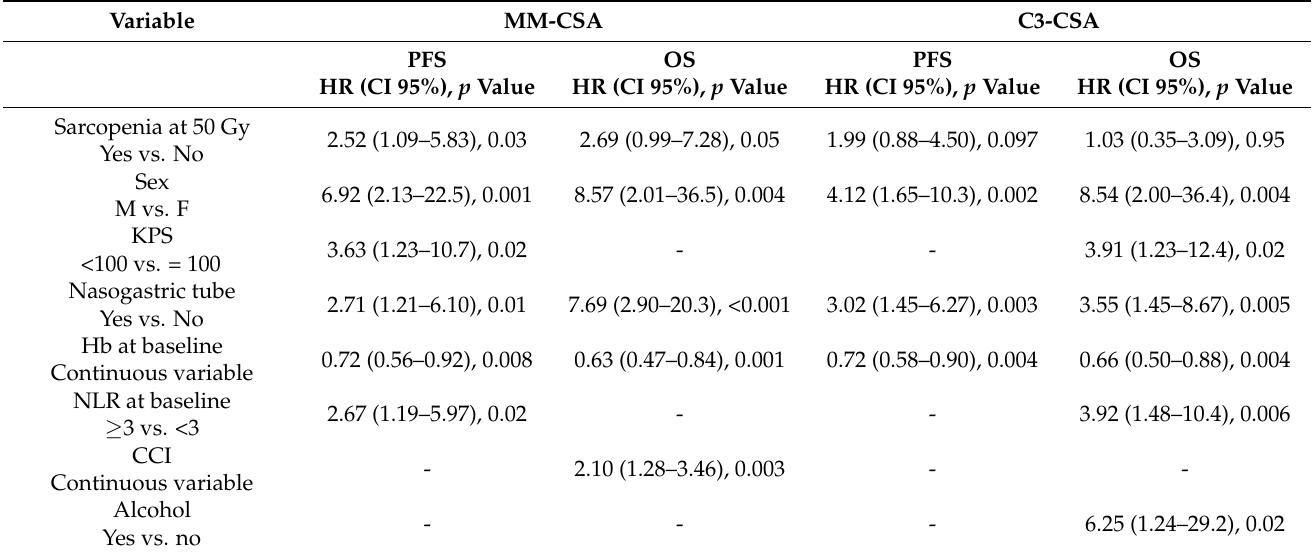
Table 2. Results of multivariable Cox proportional hazard models related to PFS and OS (sarcopenia assessment based both on MM-CSA and